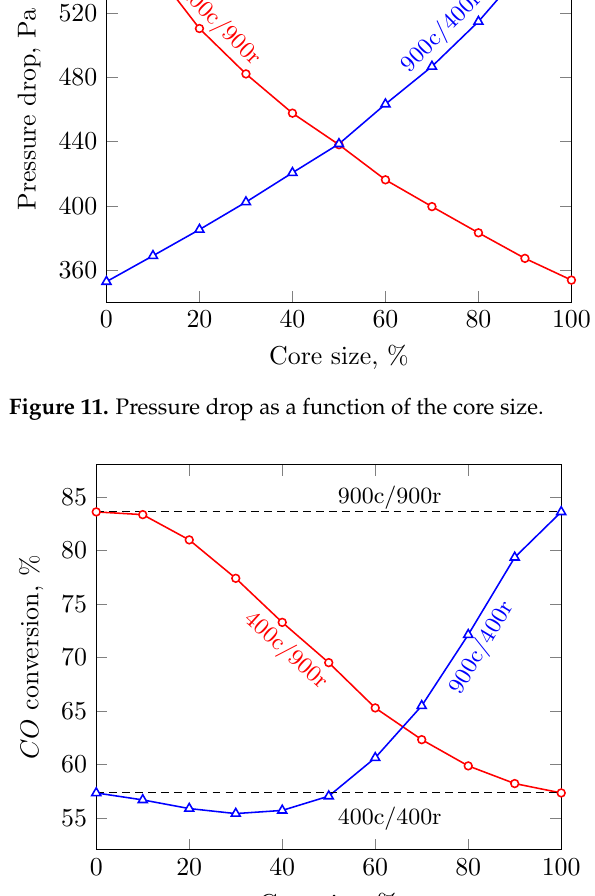
Figure 12. Overall CO conversion as a function of the core 1